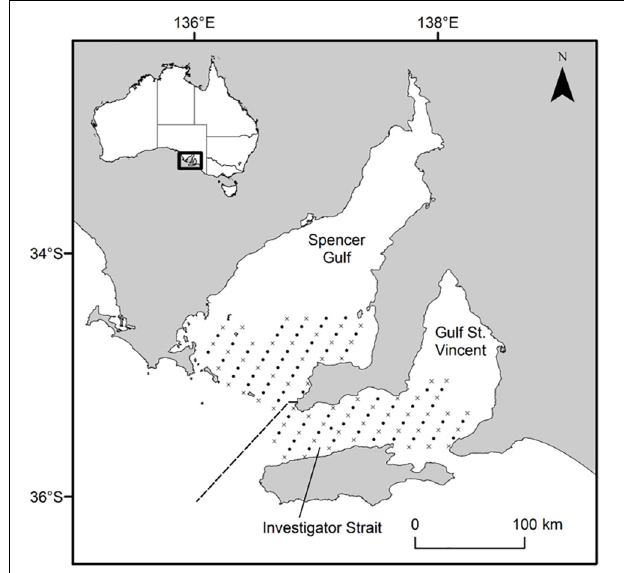
FIGURE 1 | Map of South Australia’s gulf systems showing the geo-referenced stations where plankton samples were collected in 2017 and 2018. Oblique tows ( • ) were done at every station ( n = 126) and vertical tows with CTD casts ( × ) at almost every second station ( n = 62). The dashed line separates Southern Spencer Gulf and Investigator Strait stations. Inset, map of Australia showing the study area along the southern